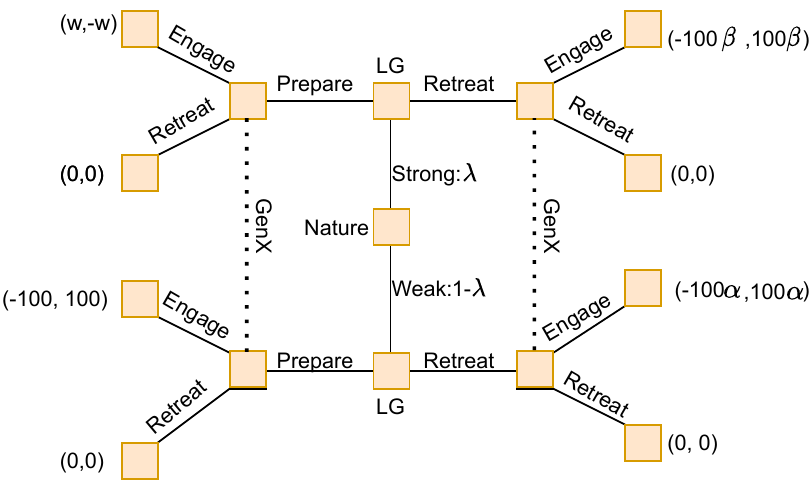
Figure 2. The 100 Horsemen signaling game [68]. In Figure 2 : LG represents the decision point for General Li Guang, of the Han forces. GenX represents the decision point for the opposing Xiongnu